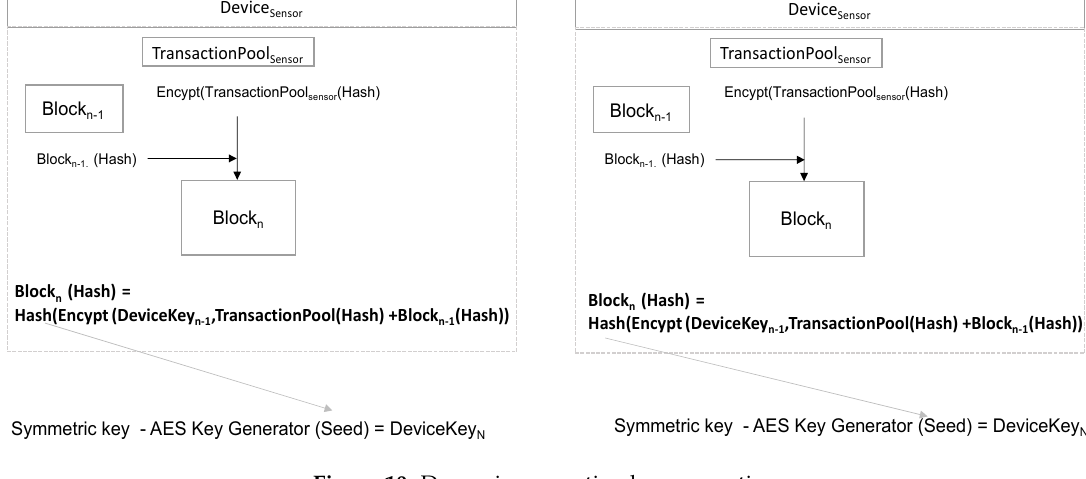
Figure 10. Dynamic encryption key generation.